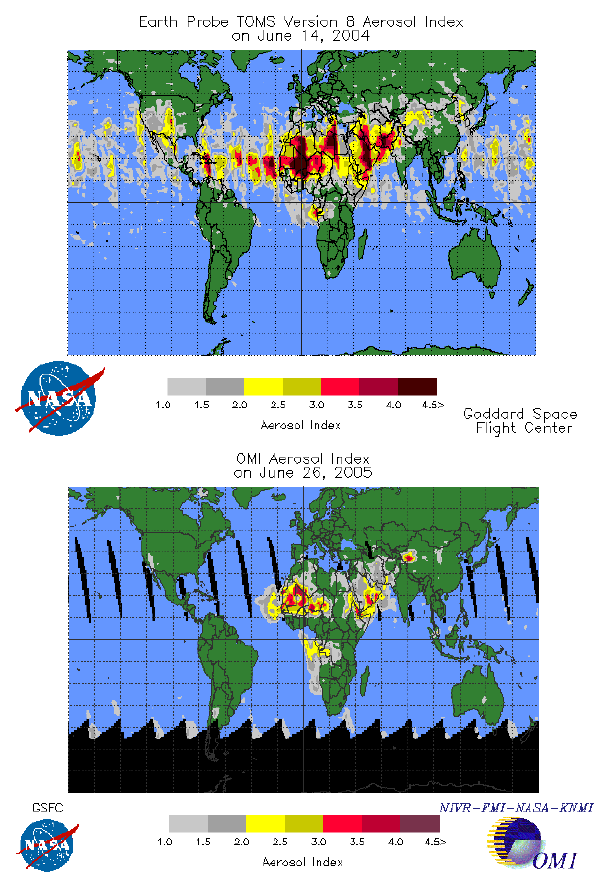
Fig. 3. Global maps of aerosol index provided by the space- craft Earth Probe-Total Ozone Mapping Spectrometer (TOMS) for 14 June 2004 and Ozone Monitoring Instrument (OMI) for 26 June 2005 (http://disc.sci.gsfc.nasa.gov/giovanni/overview/ index.html). These dates correspond to relevant Saharan dust intru- sions over the southeastern Iberian Peninsula where the atmospheric collectors were placed (see also Fig. 2 for the atmospheric deposi- tion